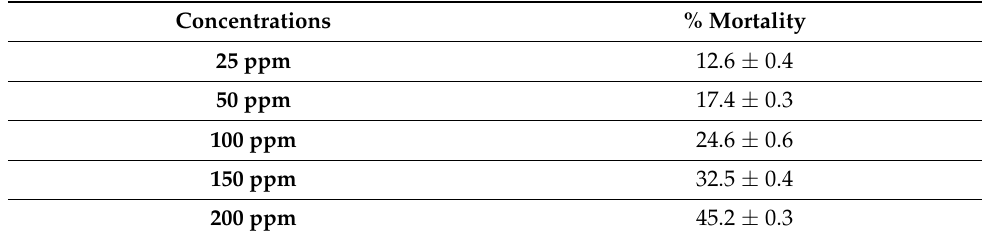
Table 3. Anti-larvicidal potential of FeNPs against Aedes aegypti .